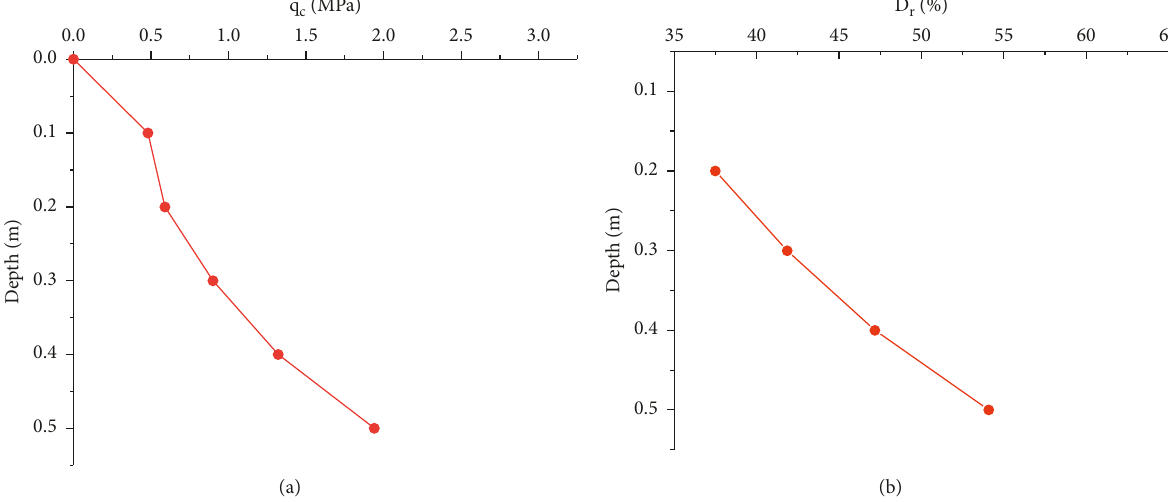
Figure 10: Initial site conditions. (a) The initial cone tip resistance variation curve of the site. (b) The initial relative site density.